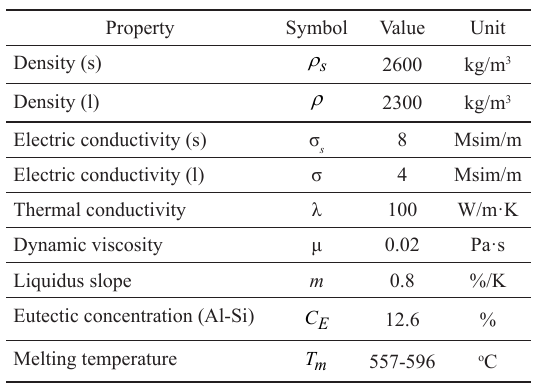
Table 1. Physical properties of A360 alloy.